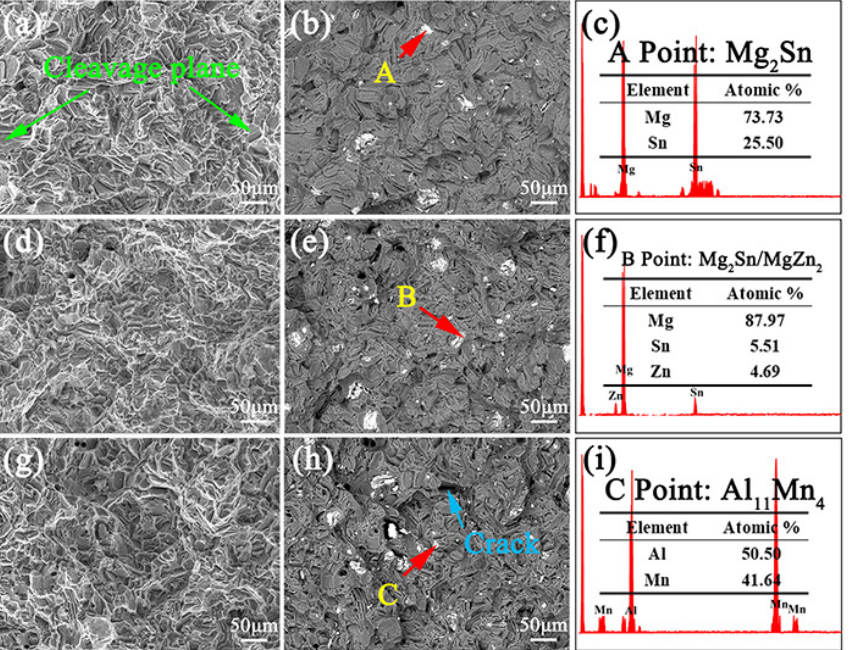
Figure 9. ( a , d , g ) SE-SEM, ( b , e , h ) BSE-SEM micrographs of fracture surface of the single-aged ZTM641-xAl alloys tested at room temperature, ( a , b ) x = 0, ( d , e ) x = 0.5, ( g , h ) x = 2, ( c , f , i ) corresponding EDS results of the points indicated in ( b , e , h ).